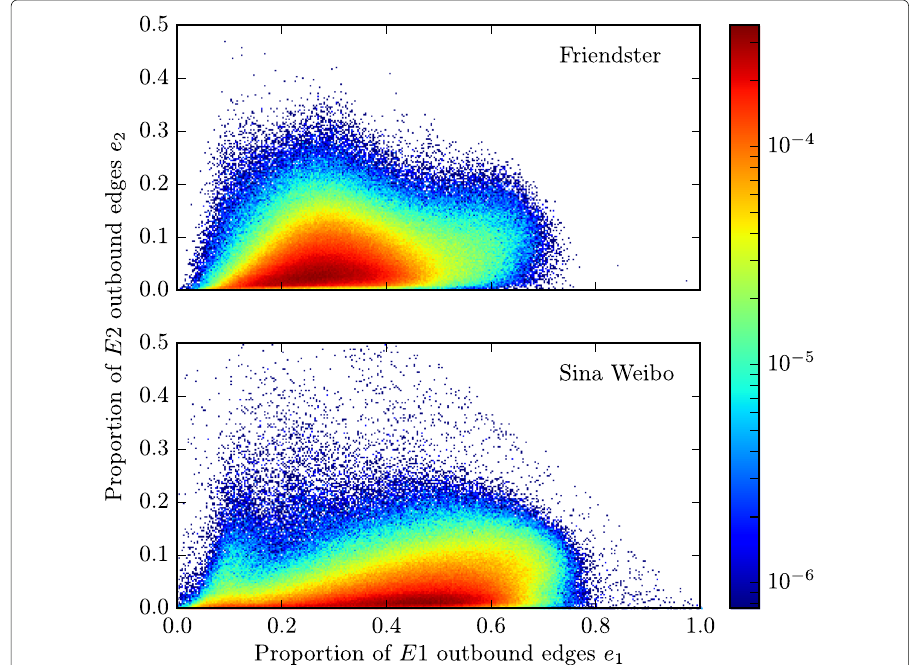
Fig. 6 Histogram of communities grouped by the proportions of E 1 and E 2 outbound edges. The numbers of bins in the x and y axes are 400 and 200, respectively. The counting in each bin is normalized by